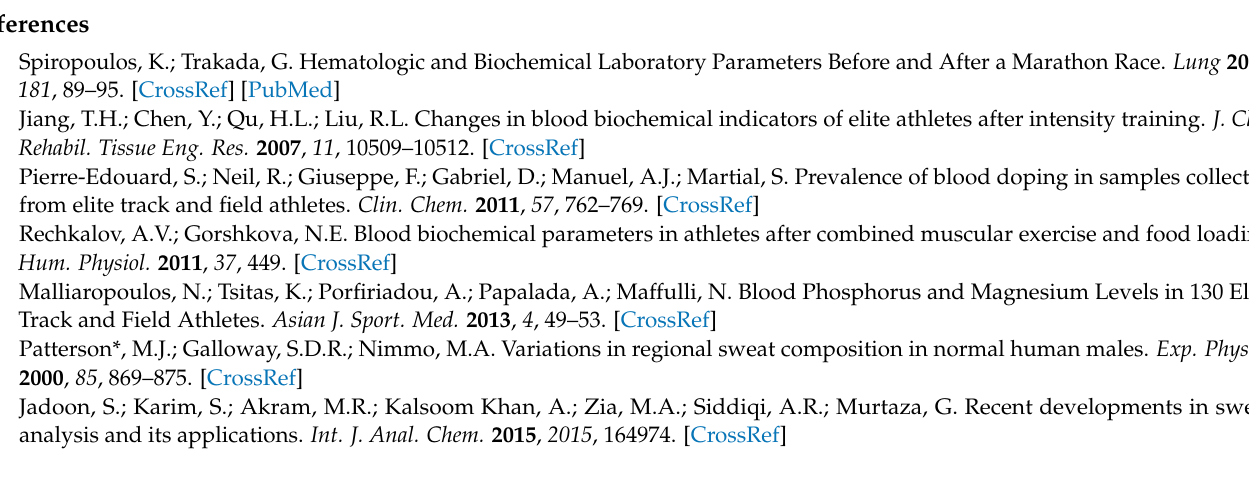
crofluidic sweat chip; Figure S2: The detailed chip design parameters; Figure S3: Paper-based glucose and pH sensors fabricated process; Figure S4: Microfluidic sweat chip chips are attached to different parts of the human body (forehead, arm, chest, etc.); Video S1: Using blue ink to test the water absorption performance of the microfluidic sweat